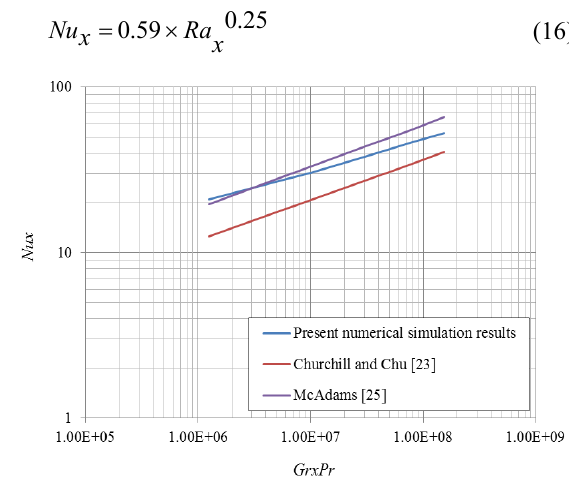
Figure 10. Analytical and numerical Nusselt number across the length of the vertical tube for the